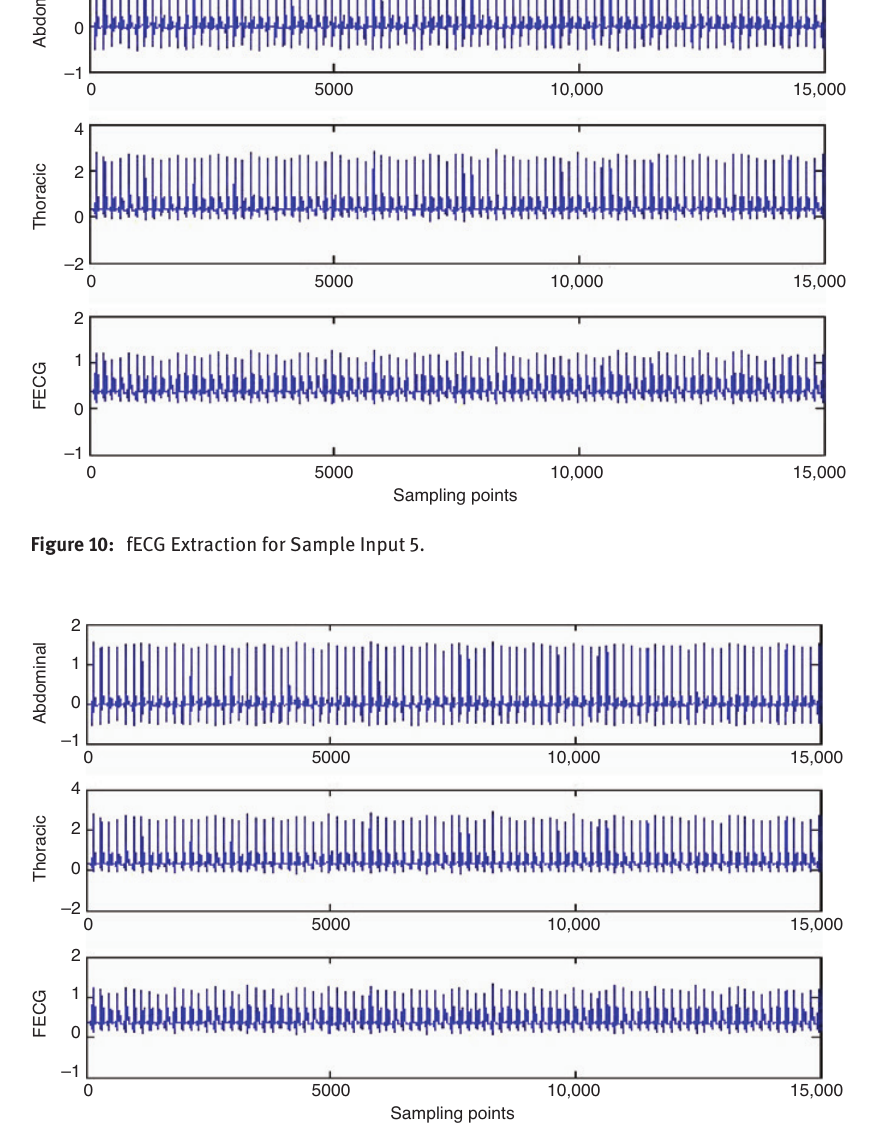
Figure 11: fECG Extraction for Sample Input